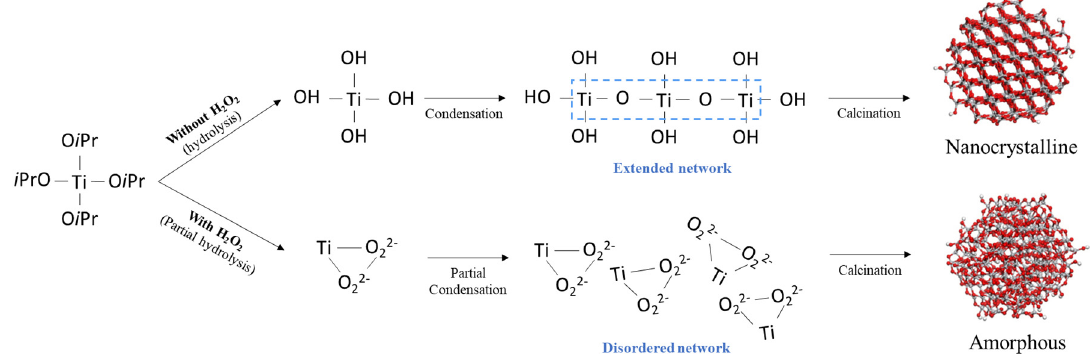
Figure 5. Schematic showing the effect of H 2 O 2 on the local structure. TTIP (Ti(O i Pr) 4 ) reacts with H 2 O and a hydrolysis reaction occurs to form -Ti-OH